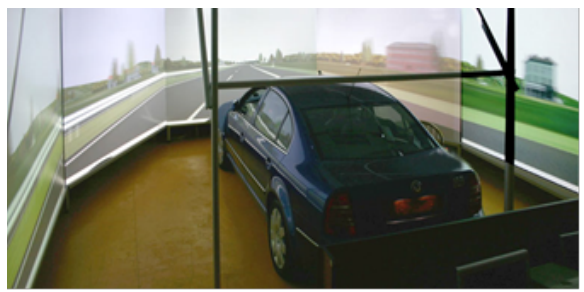
Figure 1. Advanced driver simulator for driver drowsiness research.